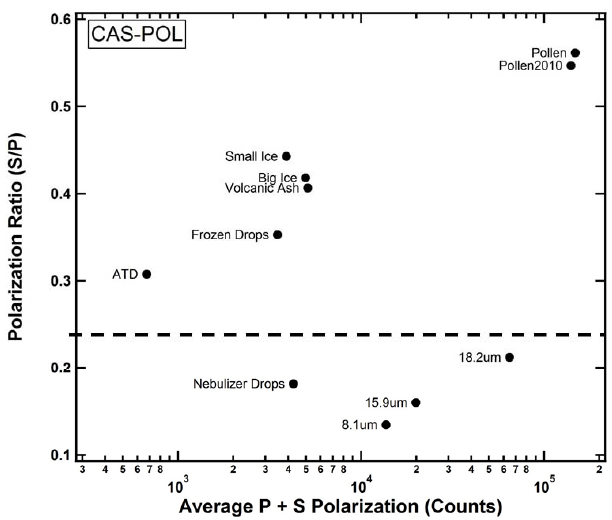
Figure 9. The average depolarization ratio as a function of the to- tal backscattering ( S plus P polarization) derived from CAS-POL measurements in the laboratory of a number of different types of particles: calibration particles, labeled by their nominal size, neb- ulized water droplets, Arizona Test Dust (ATD), volcanic ash, ice crystals and